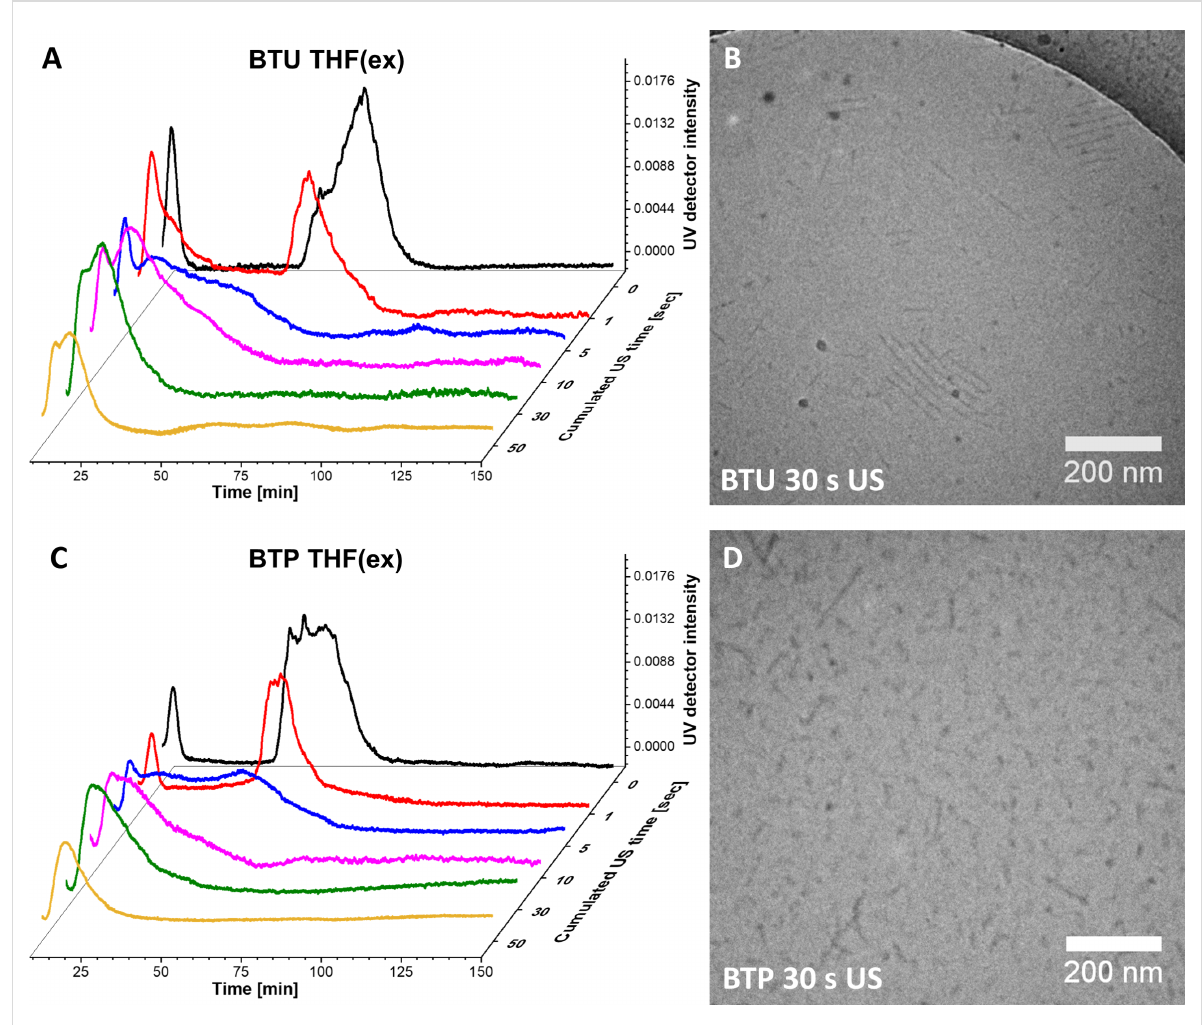
Figure 4: AF4 − UV elution profiles after US for the cumulated time of 0 s (black), 1 s (red), 5 s (blue), 10 s (magenta), 30 s (green), and 50 s (yellow) for BTU (A) and BTP (C). The injection peaks were omitted for clarity. cryoTEM images of BTU (B) and BTP (D) after 30 s of US exposure ( c = 1 mg ⋅ mL − 1